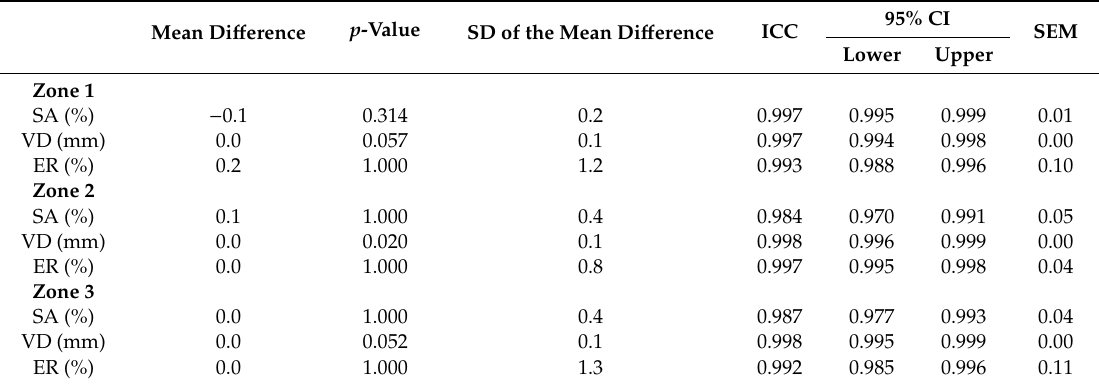
Table 2. Comparison of R1 vs. MeanR2R3 for assessing shock absorption (SA), vertical deformation (VD), and energy restitution (ER) in each zone. ‘Mean Di ff erence’ is R1 minus